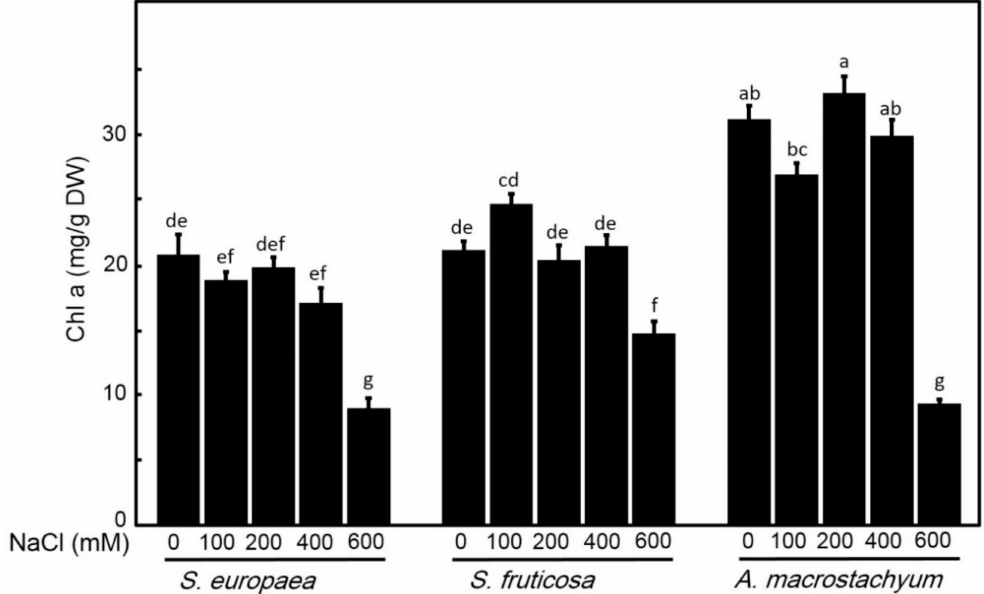
Figure 5. Chlorophyll a contents of S. europaea, S. fruticosa and A. macrostachyum under different NaCl concentrations. Mean ± SE of three replicates. Different letters indicate significant differences ( p < 0.05).